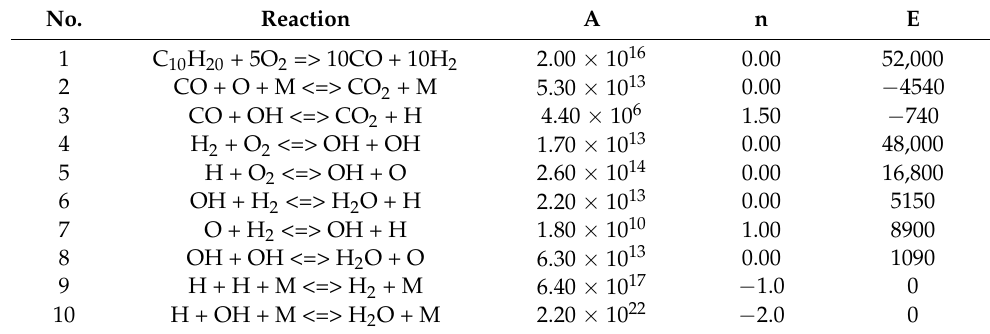
Table 2. The 10-component 10-step chemical reaction mechanism